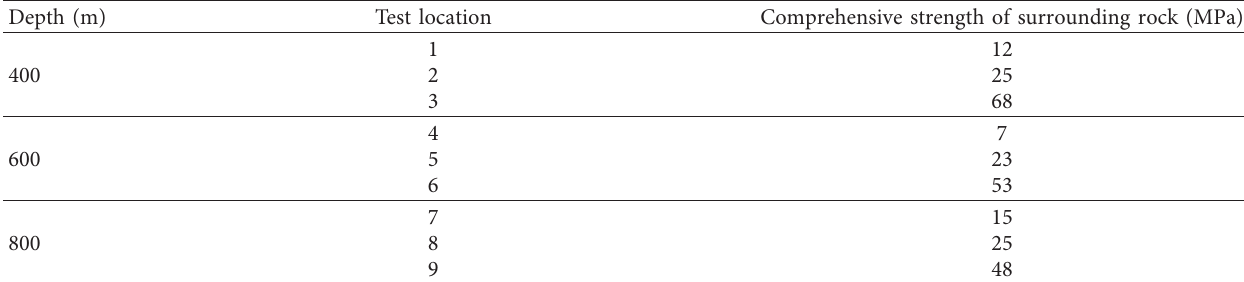
Figure 12: Data collecting and processing system. Table 5: Depth and comprehensive stress of surrounding rock of each